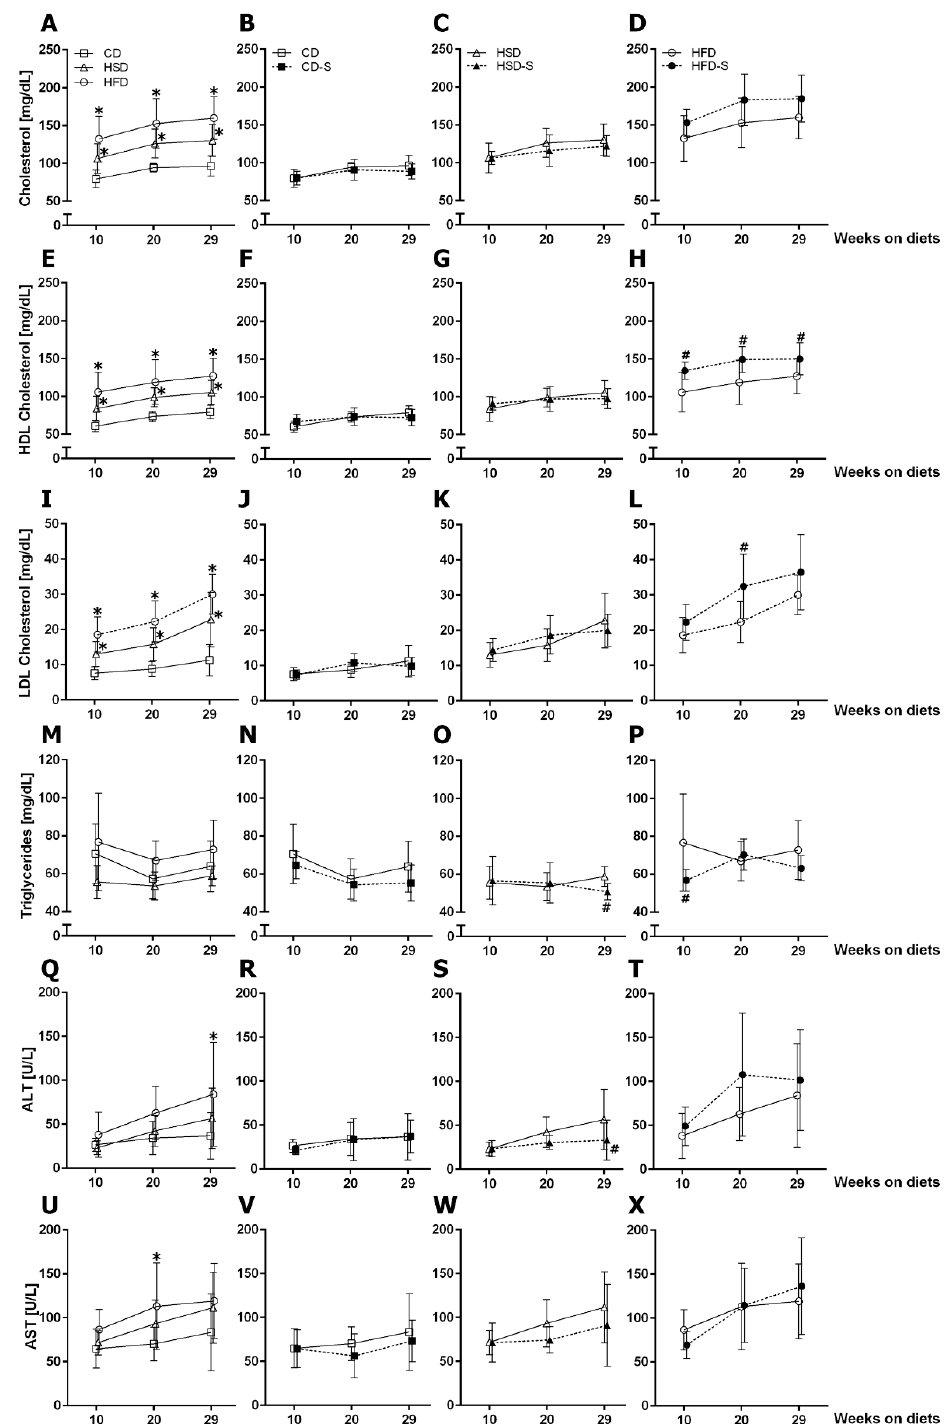
Figure 4. Effects of diets and spermidine on circulating lipids and enzymes. ( A – D ) Fasting plasma total cholesterol concentrations. ( E – H ) Fasting plasma HDL cholesterol concentrations. ( I – L ) Fasting plasma LDL cholesterol concentrations. ( M – P ) Fasting plasma triglyceride concentrations. ( Q – T ) Fasting plasma alanine transaminase concentrations. ( U – X ) Fasting plasma aspartate transaminase concentrations. Values are group means ± SD; CD n = 10, CD-S n = 10, HSD n = 10, HSD-S n = 9, HFD n = 8, HFD-S n = 9. Data were compared separately for diet and spermidine effects by 2W- RM-ANOVA followed by Tukey test; p -values < 0.05 are indicated by * for dietary effect or # for spermidine effect. CD, control diet; HSD, high sucrose diet; HFD, high fat diet; -S,